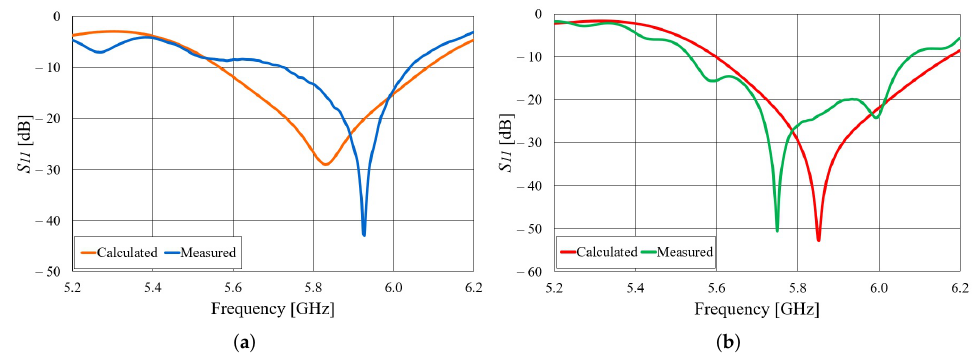
Figure 5. S 11 parameter of the realized slotted waveguide antennas: ( a ) Textile antenna, ( b ) aluminum antenna.